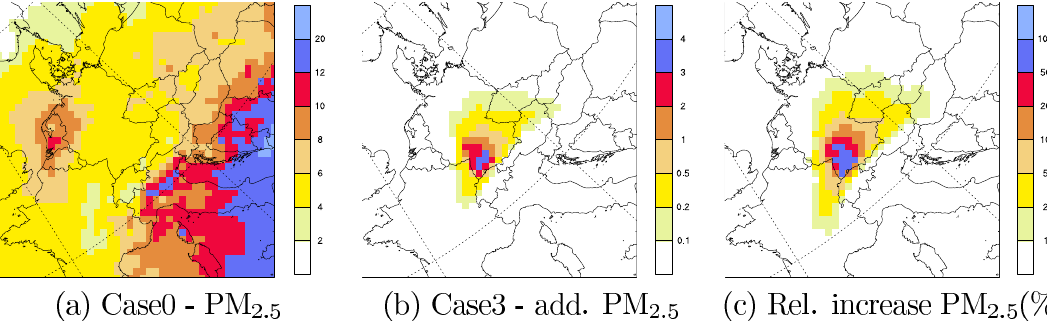
Figure 8. Model calculated regional background PM 2 . 5 concentration (2-month-mean for Jun–Jul). (a) Total model PM 2 . 5 without explicit biotic stress emissions (Case 0) (µgm − 3 ); (b) Additional PM 2 . 5 due to organic aerosol formation caused by biotic stress-induced emissions in Case 3 (infestation of Spruce in Baden-Württemberg by Cinara pilicornis ) (µgm − 3 ); (c) Relative increase in modelled regional background PM 2 . 5 (in %) due to the simulated